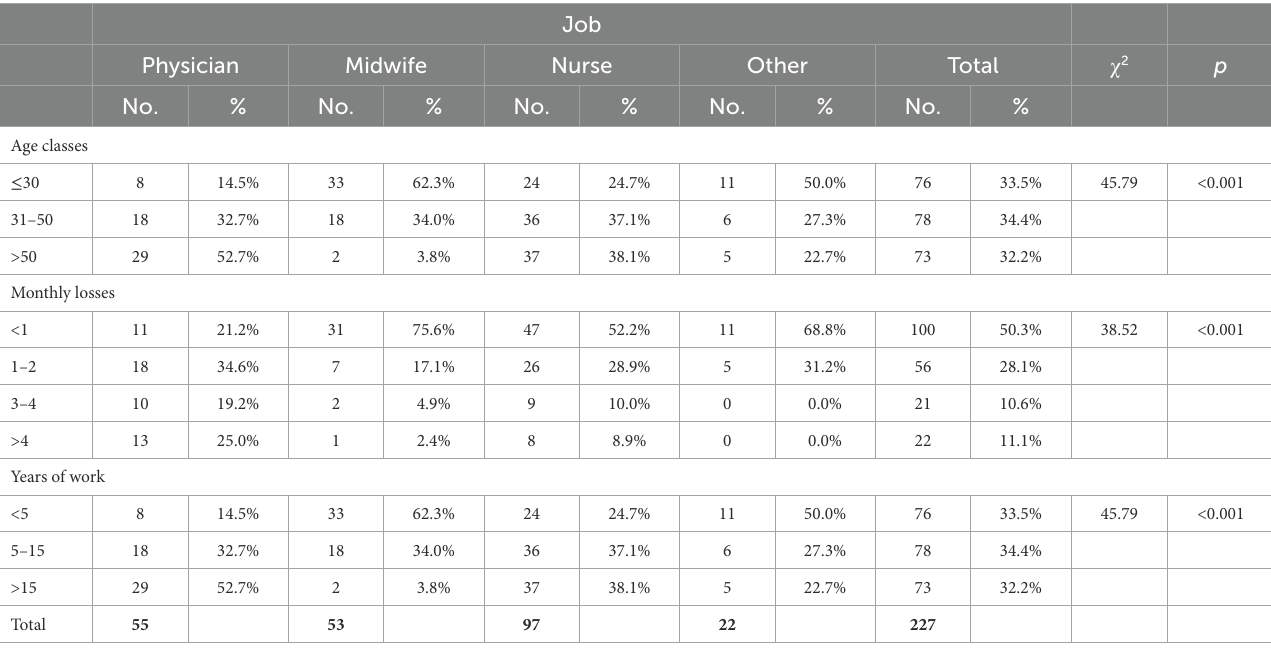
TABLE 1 Characteristics of the